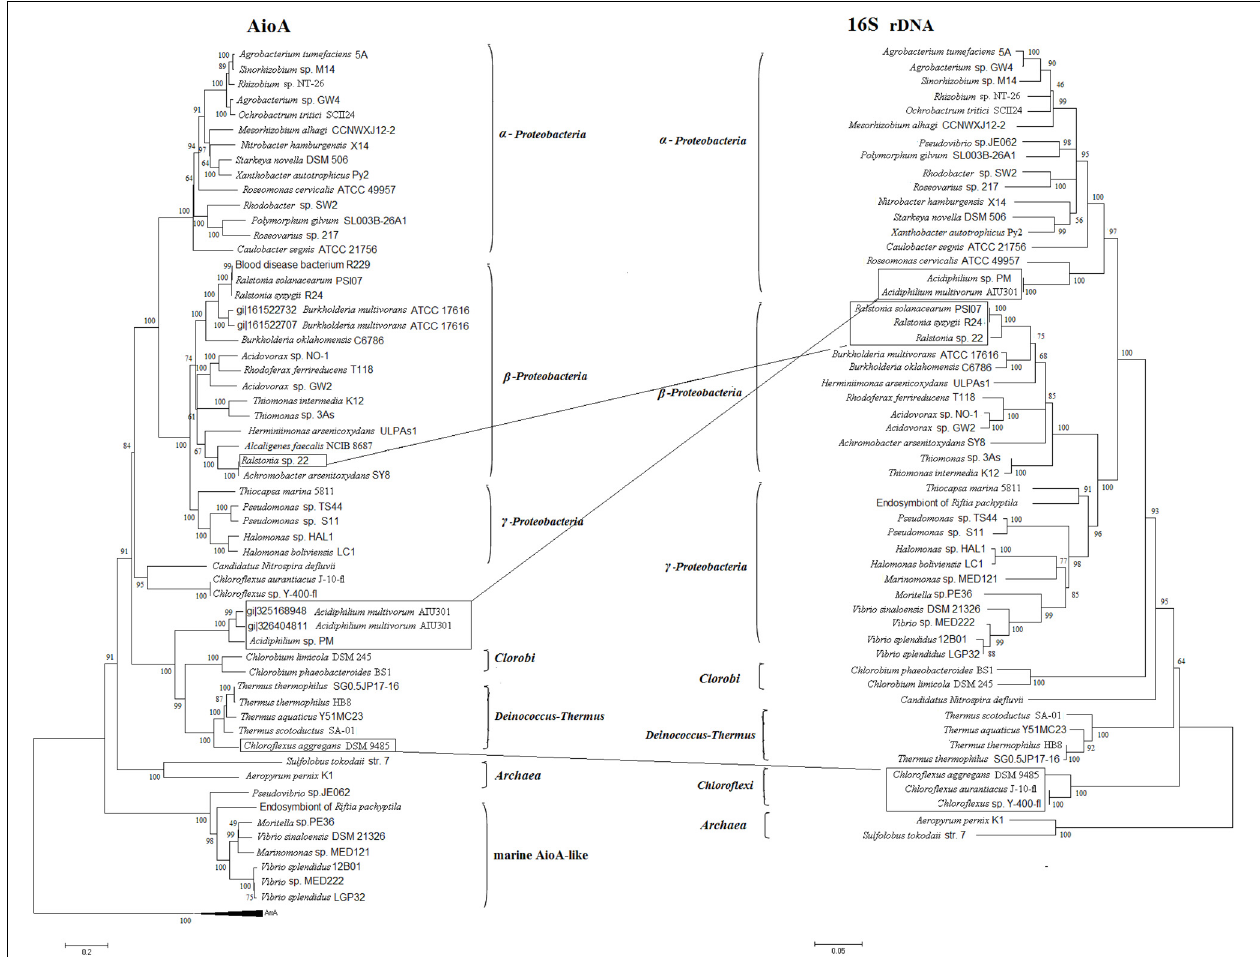
FIGURE 2 | The neighbor-joining (NJ) phylogenetic trees of AioA sequences and 16S rDNA sequences. Putative horizontal gene transfer events (labeled with frames) have been compared based on the inconsistency of AioA amino acid tree (on the left) and the 16S rDNA tree (on the right).